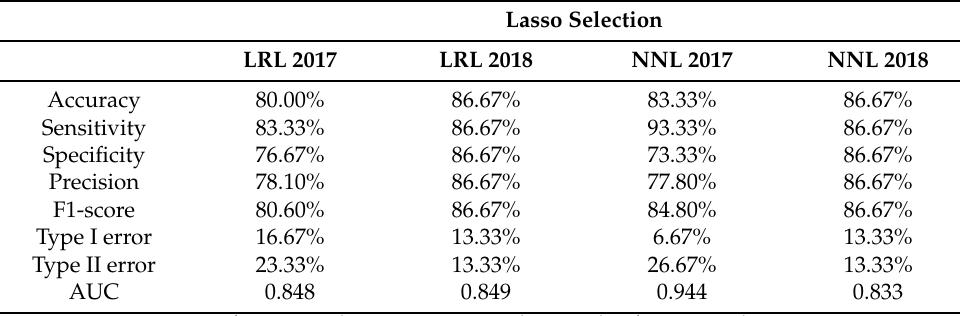
Table 10. Model performance metrics for lasso selection